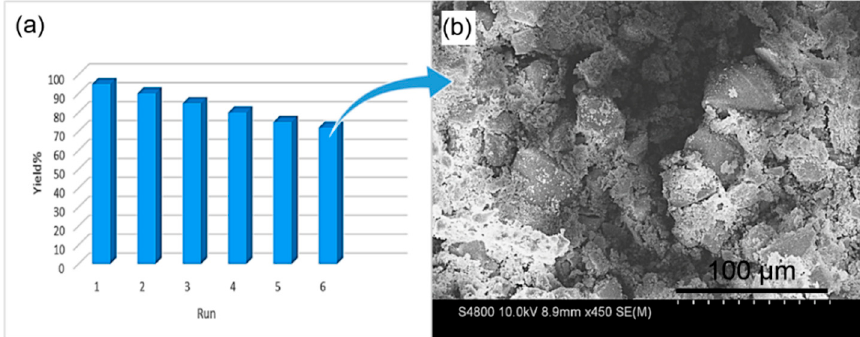
Figure 5. ( a ) Recyclability study of Pd@Bipy–PMO catalyst in Suzuki reaction, and ( b ) the corresponding FESEM image after 6 th